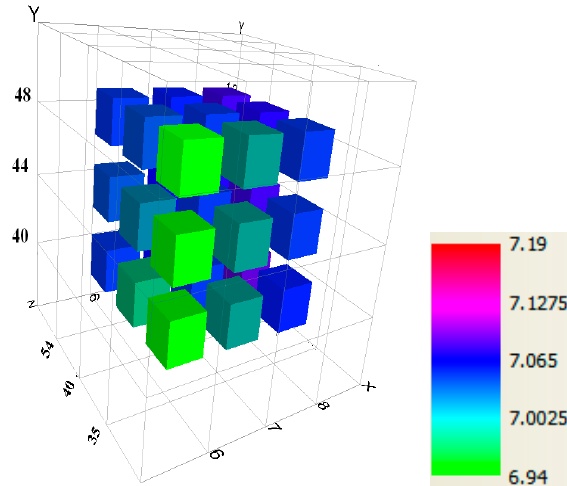
Figure 9. E ff ects of P m , P e, and N bat on fuel consumption per 100 Figure 9. Effects of P m , P e, and N bat on fuel consumption per 100 km.